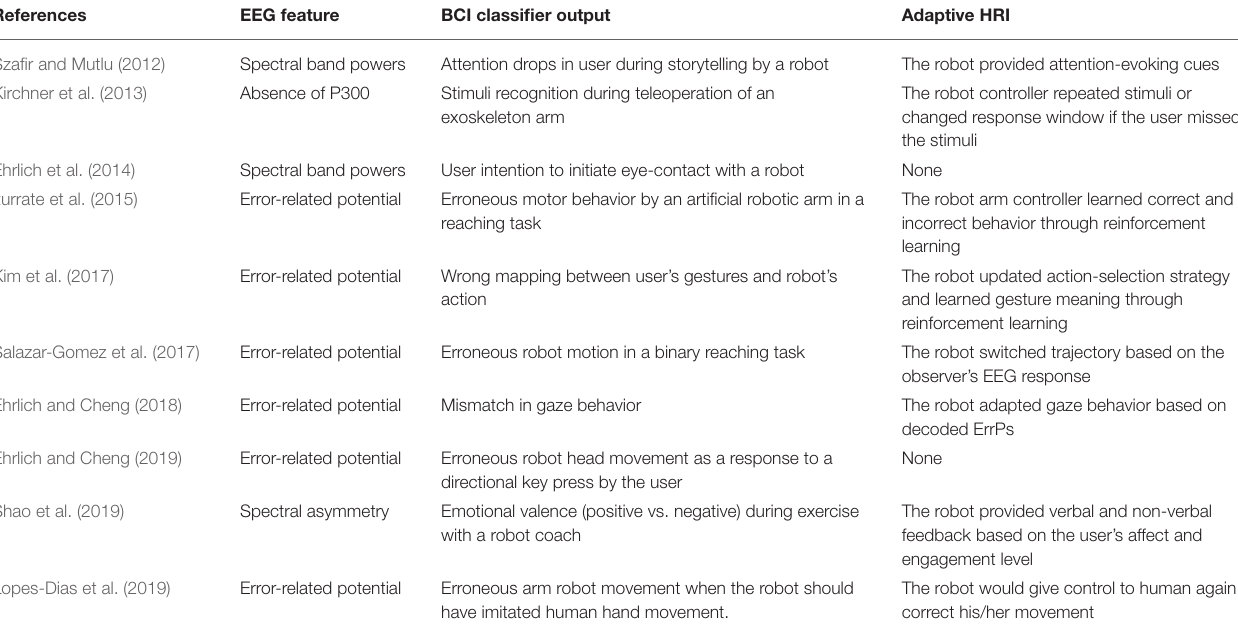
TABLE 2 | List of articles in the literature that used a passive BCI classifier for extraction of user’s cognitive and affective state during interaction with a physical